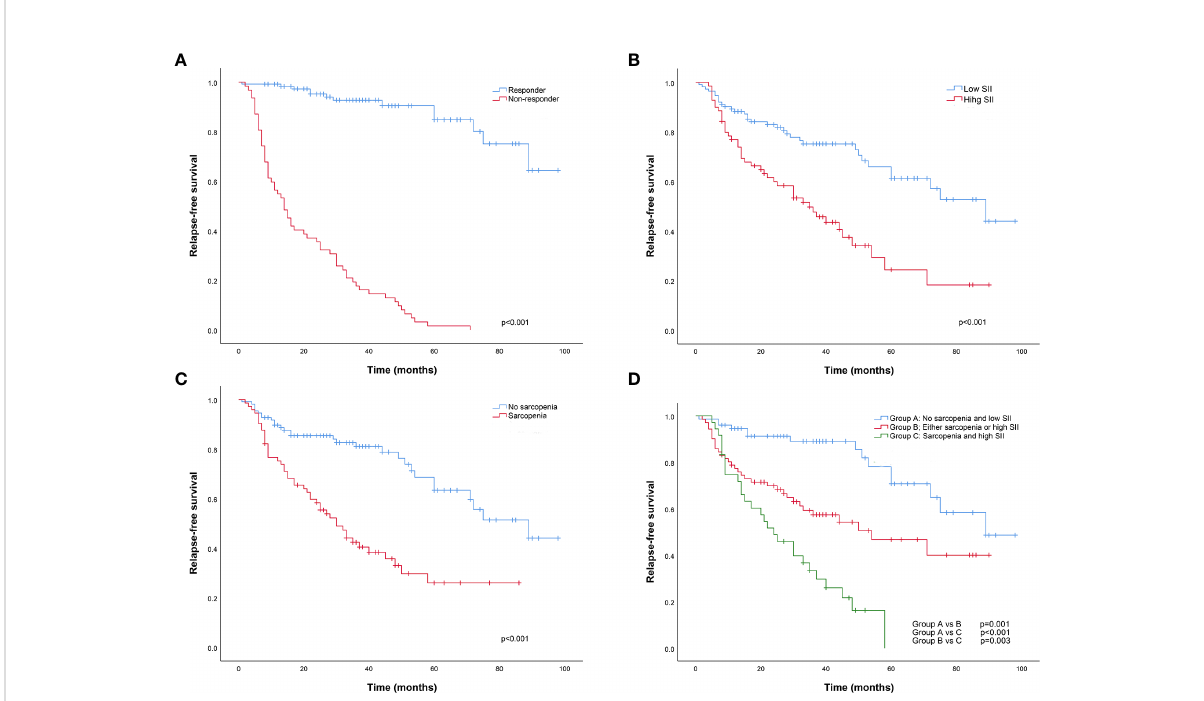
FIGURE 5 The Kaplan-Meier relapse-free survival analysis between BCG responder and non-responder (A) , low and high SII group (B) , no sarcopenia and sarcopenia group (C) , No sarcopenia and low SII group, Either sarcopenia or high SII group, and Sarcopenia and high SII group (D) , respectively. BCG, Bacillus Calmette-Guerin; SII, Systemic Immune-In fl ammation